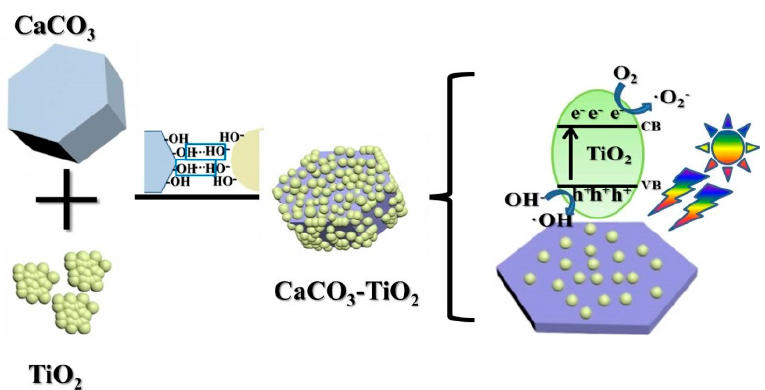
Figure 9. Improvement mechanism of photocatalytic performance.